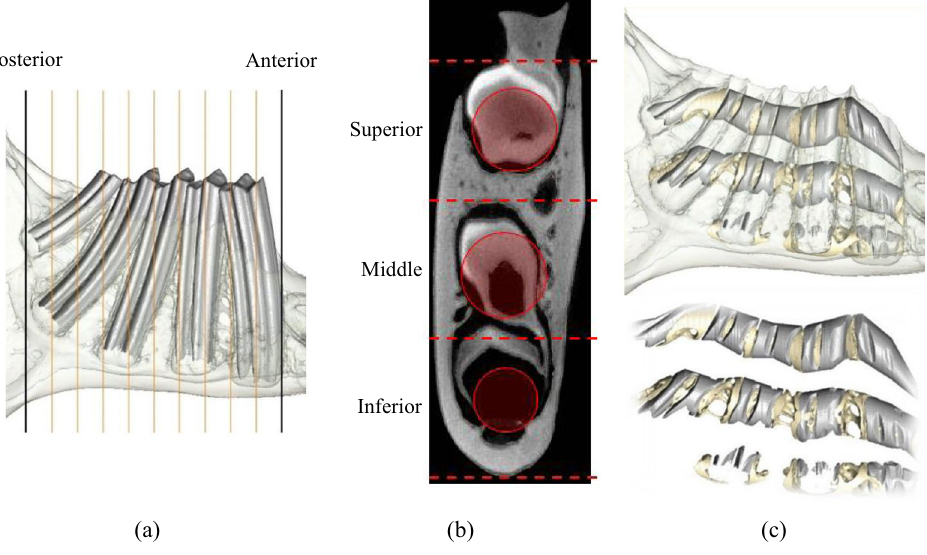
Figure 6. Methodology used to calculate the volume fractions of bone and tooth material throughout the post-canine mandibular body. Construction of extruded volumes through the tooth row, showing: ( a ) division of the tooth row into 10 equally spaced regions using transverse slices between the anterior border of the first premolar, and the inferior borders of the last molar (black lines); ( b ) division of each transverse slice identified in part ( a ) into three equally spaced regions between the superior and inferior borders of the bone. A circular area was defined in the centre of each region, with the largest diameter that did not encroach the medial and lateral cortex; and, ( c ) interpolation between the areas circular areas defined in part ( b ) to create extruded VOI which followed curved trajectories through the superior, middle and inferior